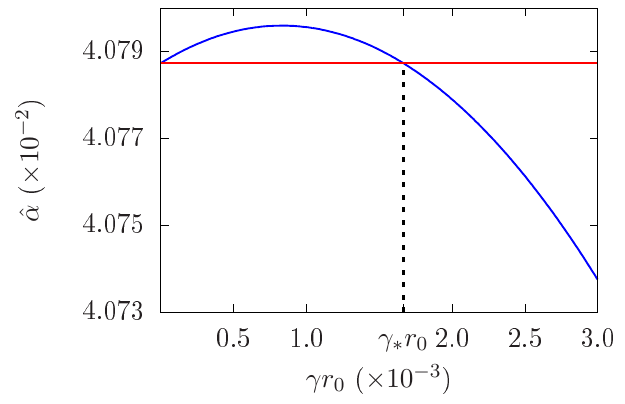
Figure 2. (Colour online.) Plot of ˆ α vs. γ r 0 , for m = 0 . 01 r 0 , k = 0, and β = 0. The horizontal red line corresponds to the Schwarzschild deflection value. In this case, we find that the deflection is greater than the Schwarzschild case for the range 0 < γ < γ